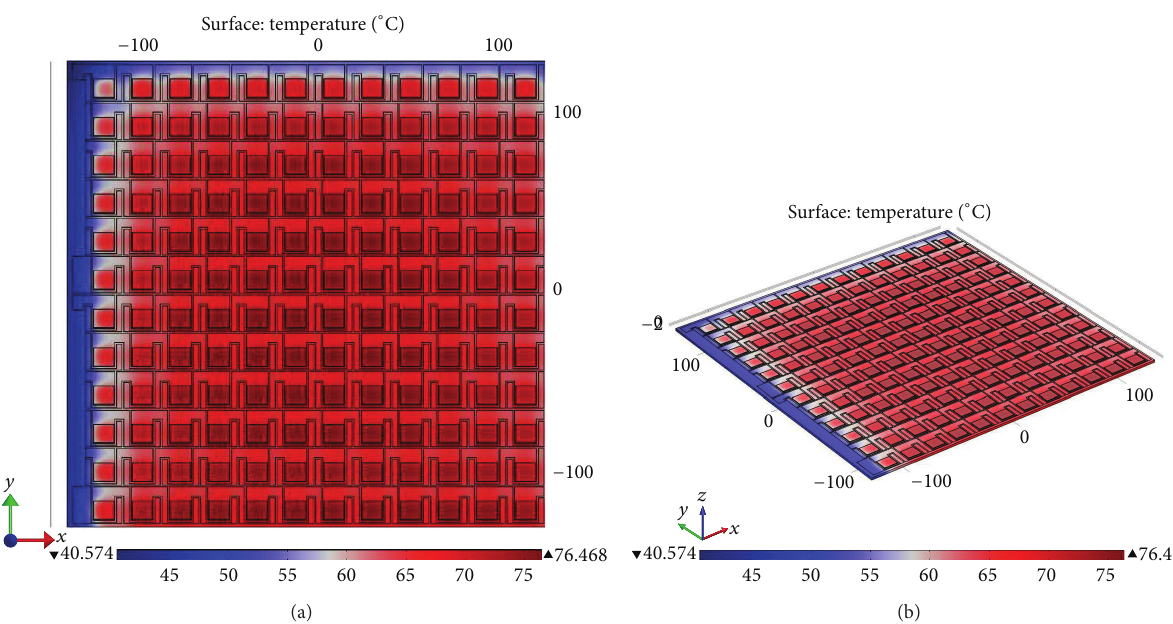
Figure 7: Front view (a) and lateral view (b) of the temperature distribution of the full scaled board in ∘ C. Max. cell’s temperature: 76.5 ∘ C. Min. cell’s temperature: 62.5 ∘ C.